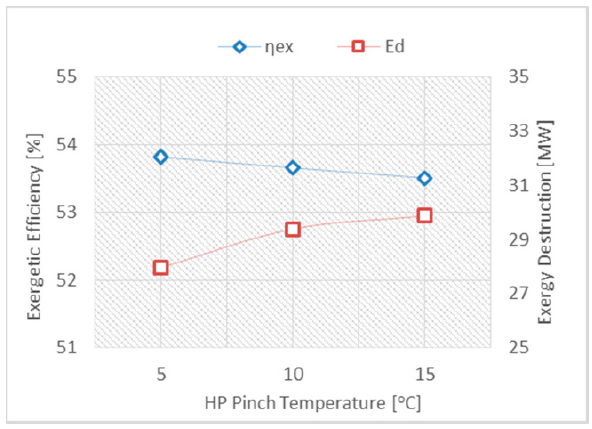
Figure 7. Exergetic efficiency and exergy destruction versus HP Pinch Temperature.